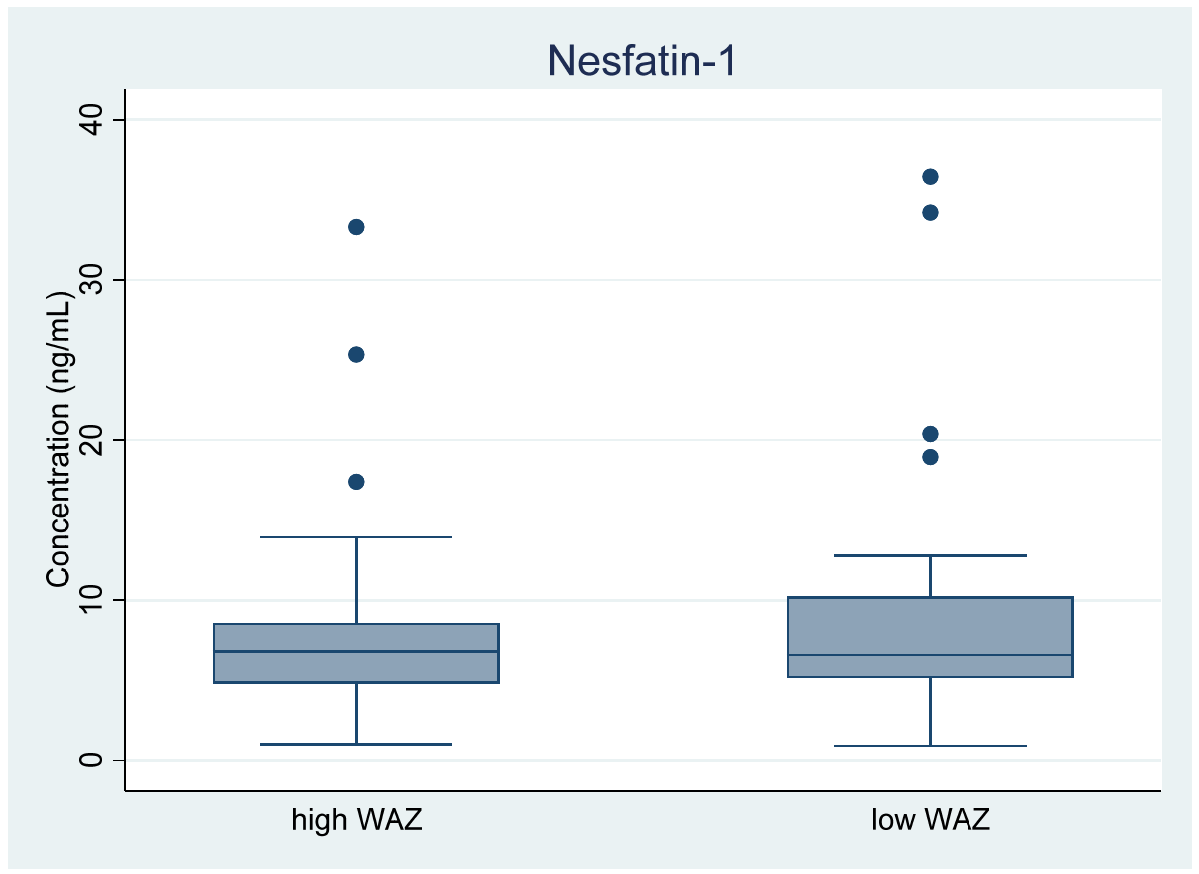
Figure 2. Nesfatin-1 levels in human milk, comparing high and low weight-for-age Z-score (WAZ) groups. Table 2. Multivariate linear regressions for anthropometrical measures and growth